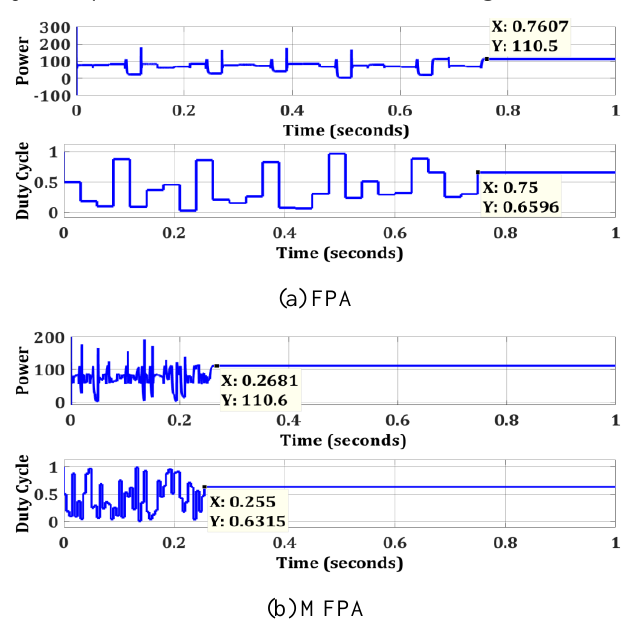
Fig. 11. Performance assessment of (a) FPA and (b) MFPA under weak PSC